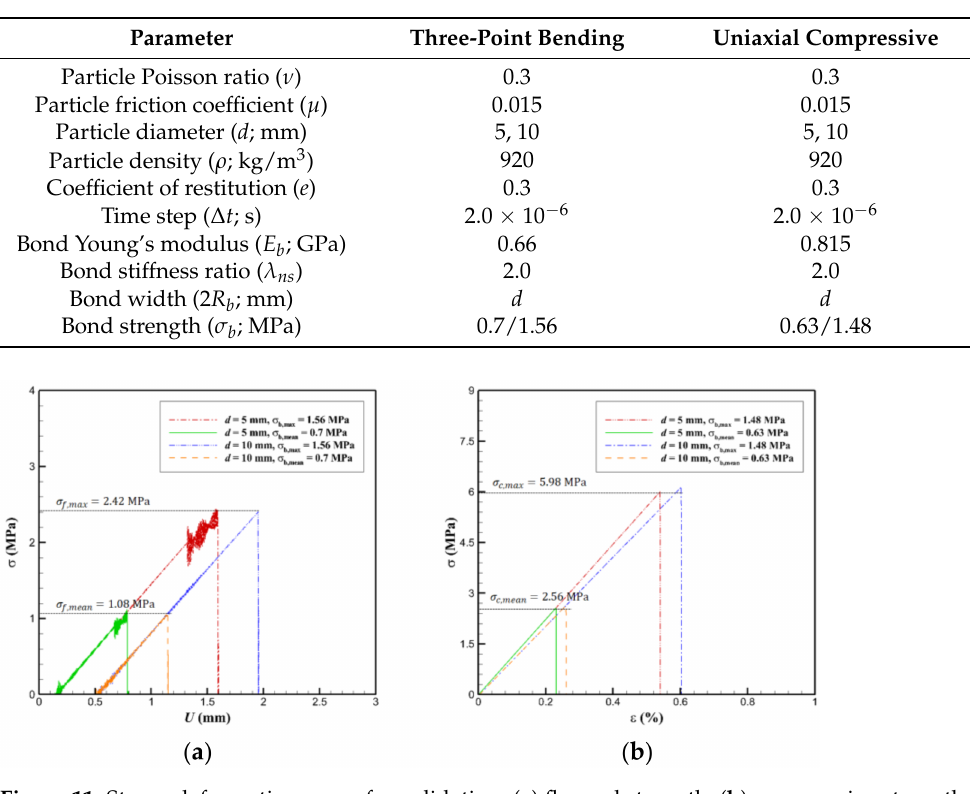
Table 3. Parameters for ice modeling in the Bohai Sea.